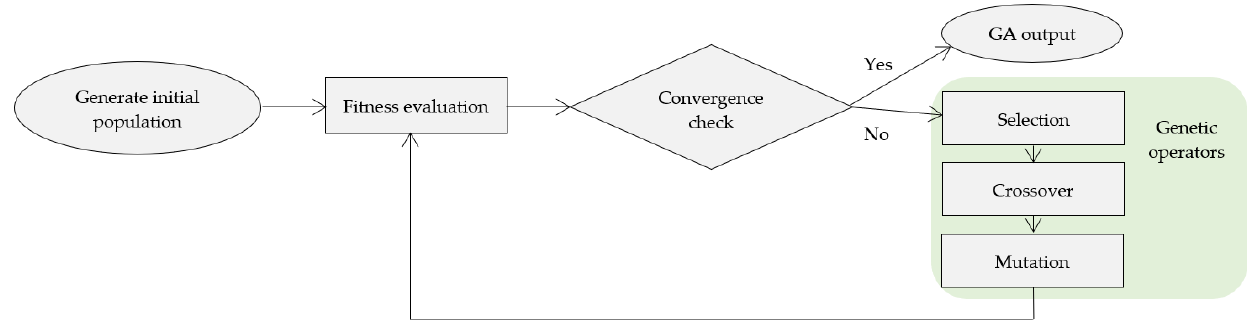
Figure 1. Flow chart of the genetic algorithm.